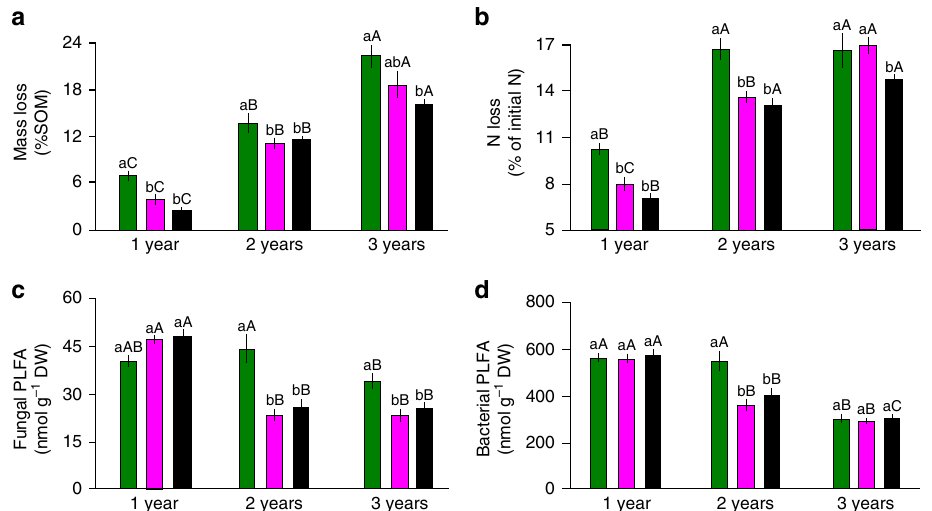
Fig. 2 Soil decomposition and microbiology: a Soil organic matter (SOM) loss, b N loss, c PLFA fungal biomarkers, d PLFA bacterial biomarkers. The different mesh sizes are represented with different colours (from left to right): 1000 µ m (green), 50 µ m (magenta), and 1 µ m (black). The given values are the means of 24 replicates. Signi fi cant differences ( P < 0.05) between treatments within 1 year are indicated by different letters, and the differences between different years for the same treatment are indicated by capital letters. The error bars represent ±s.e.m. Source data are provided as a